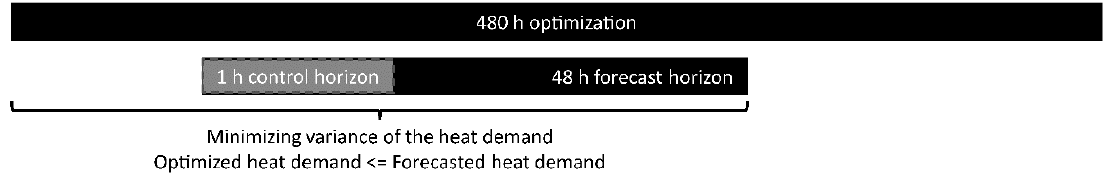
Figure 1. The optimization of the heat demand for 480 h by minimizing the variance of the heat demand.